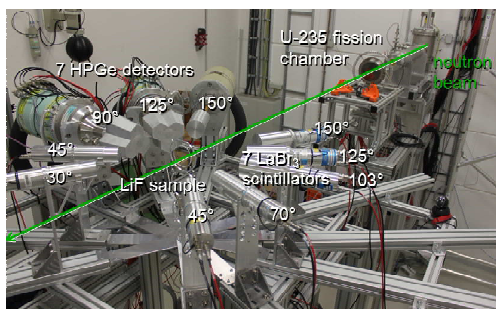
Figure 1. Currently available cross section data for 7 Li(n,n’ γ ). Data taken from [2] and references therein.